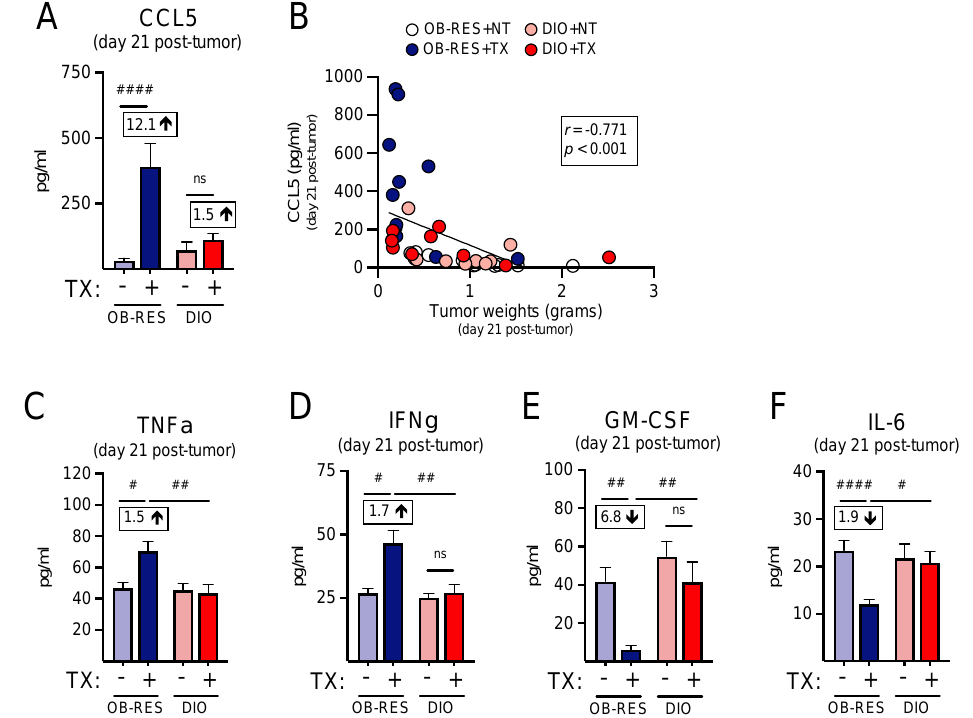
Figure 4. Therapy-treated OB-RES mice possess a tumor milieu favoring T cell chemoattractant signals and reductions in pro-inflammatory mediators. ( A ) The concentration of CCL5 from tumor homogenates at day 21 post-tumor challenge. ( B ) Linear regression of CCL5 concentrations versus tumor weights. The concentration of ( C ) TNFα, ( D ) IFNγ, ( E ) GM-CSF, and ( F ) IL-6 from tumor homogenates at day 21 post-tumor challenge. Data from n = 2 independent experiments. Fold change value calculated using no therapy control for each group. # denotes non-parametric test. # p < 0.05, ## p < 0.01, #### p < 0.0001. ns: non-significant, NT: no therapy, TX: AdT/CpG+ α